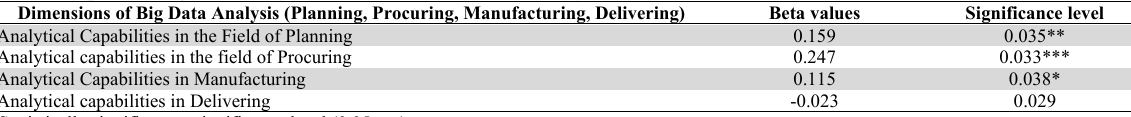
Indirect impact of big data analysis on the use of information systems Dimensions of Big Data Analysis (Planning, Procuring, Manufacturing,